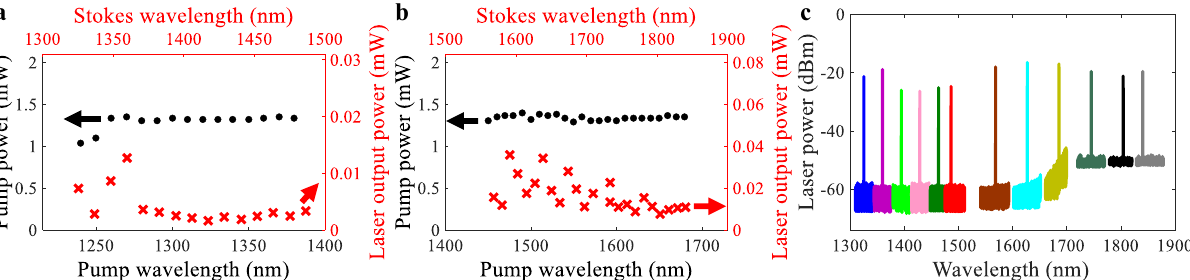
Fig. 4 Stokes Raman lasing output characteristics. a , b Pump powers used in the measurement at pump wavelengths with 10 nm spacings from 1240 to 1380 nm and from 1450 to 1680 nm. The corresponding Stokes laser output powers were observed in the Stokes wavelengths from 1325 to 1487 nm and from 1569 to 1841 nm. c Selective Stokes Raman laser output spectra at pump wavelengths of 1239.9, 1270.1, 1300.2, 1329.9, 1359.9, 1379.9, 1450.4, 1500.3, 1550, 1600.2, 1650.2, and 1680 nm. Table 1 Comparison of widely tunable Raman